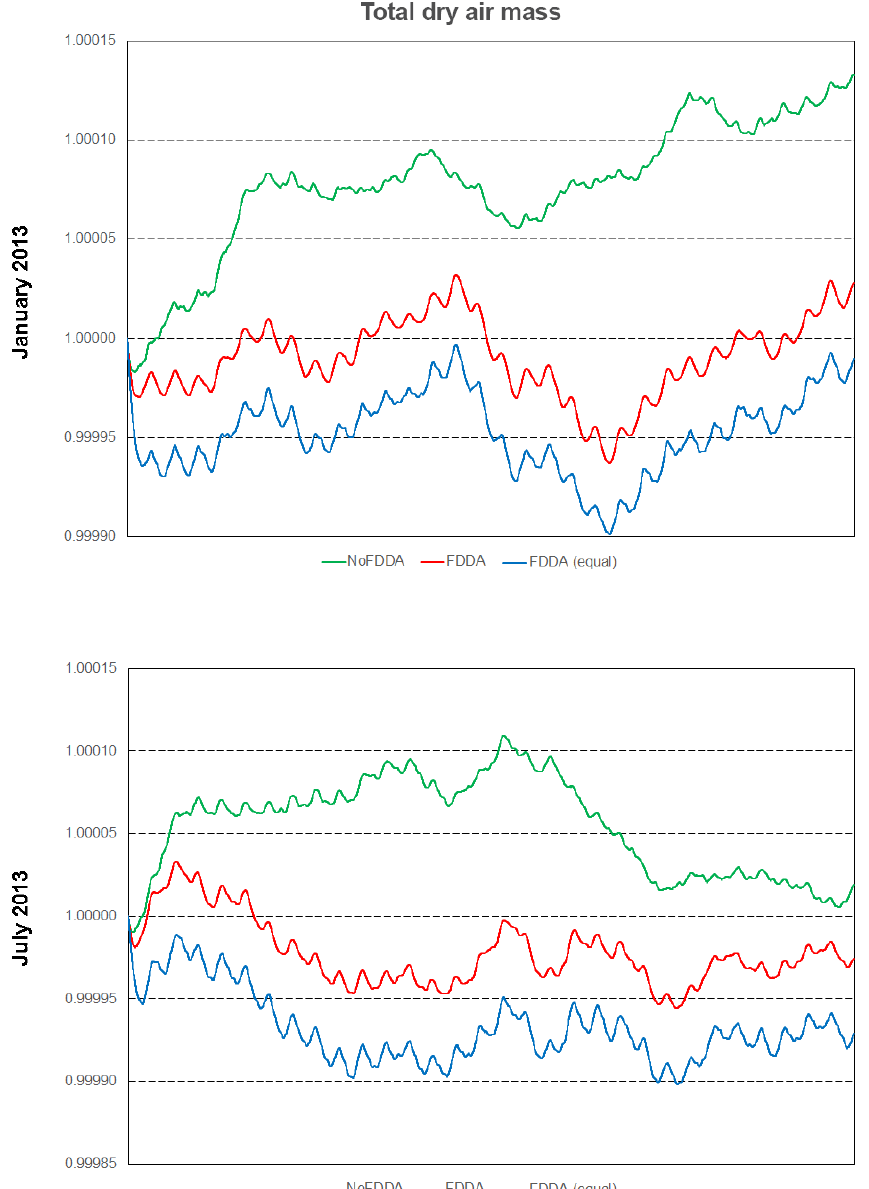
Figure 20. Time series plots of total dry air mass scaled to their initial values for the two test periods. Results are from MPAS-A without FDDA (green line), MPAS-A using weaker q v nudging (red line), and MPAS-A using equal nudging for all variables (blue